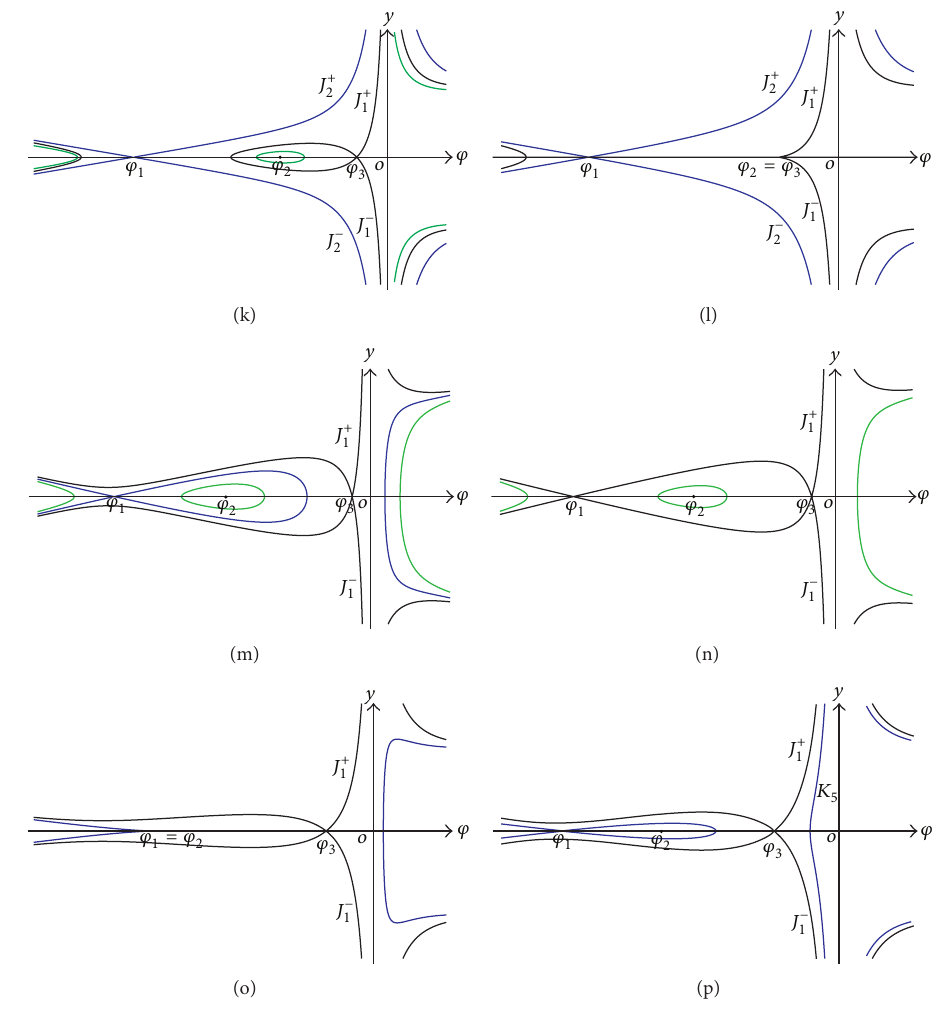
Figure 1: The phase portraits of system (10) in different cases 𝑖 ( 𝑖 =